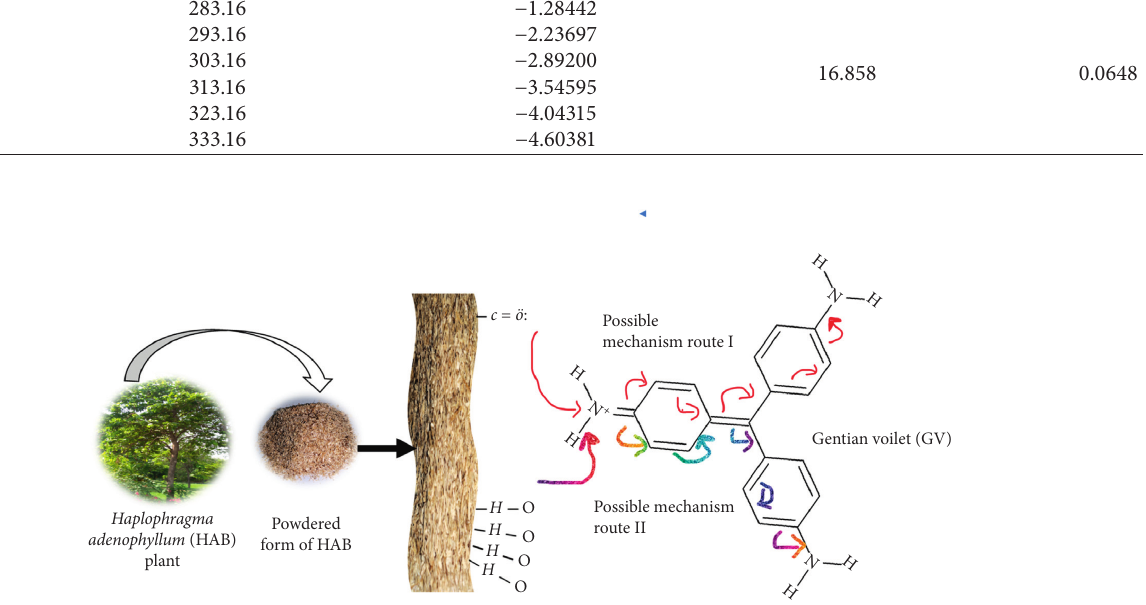
Figure 9: Possible mechanism routes of GV removal by HAB. Table 5: Comparison of GV sorption onto various used adsorbents.